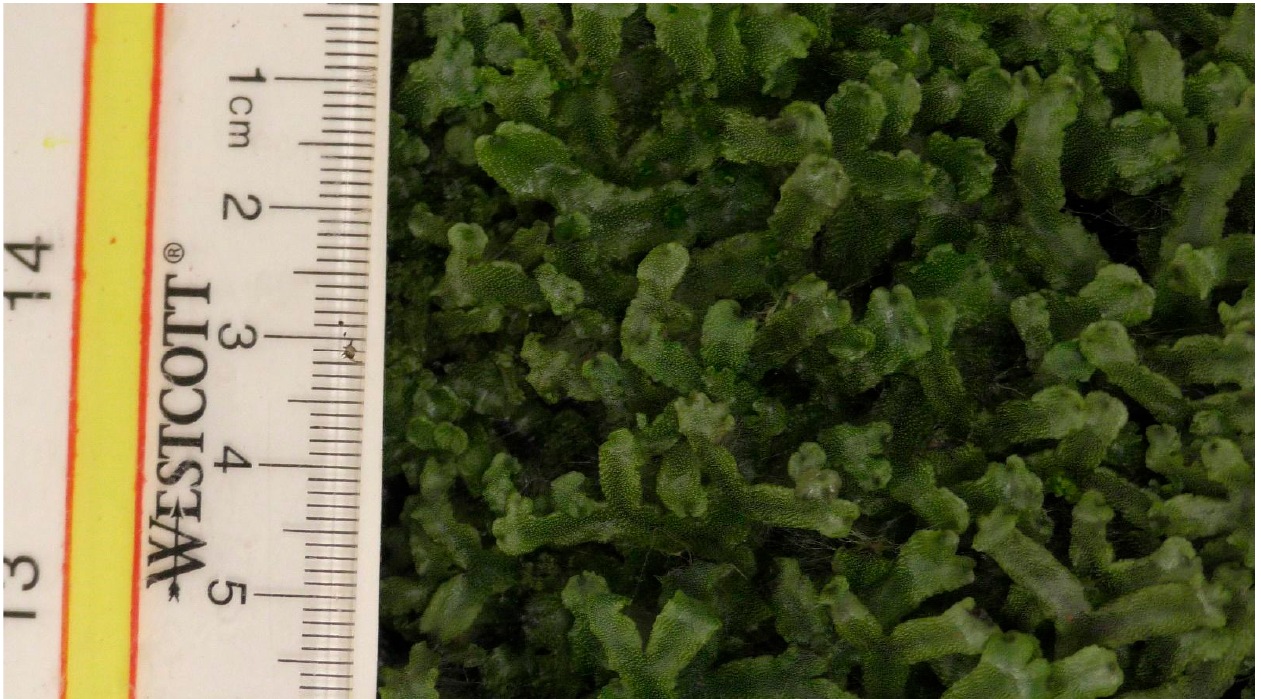
Figure A5. Liver wort Marchantia inflexa.